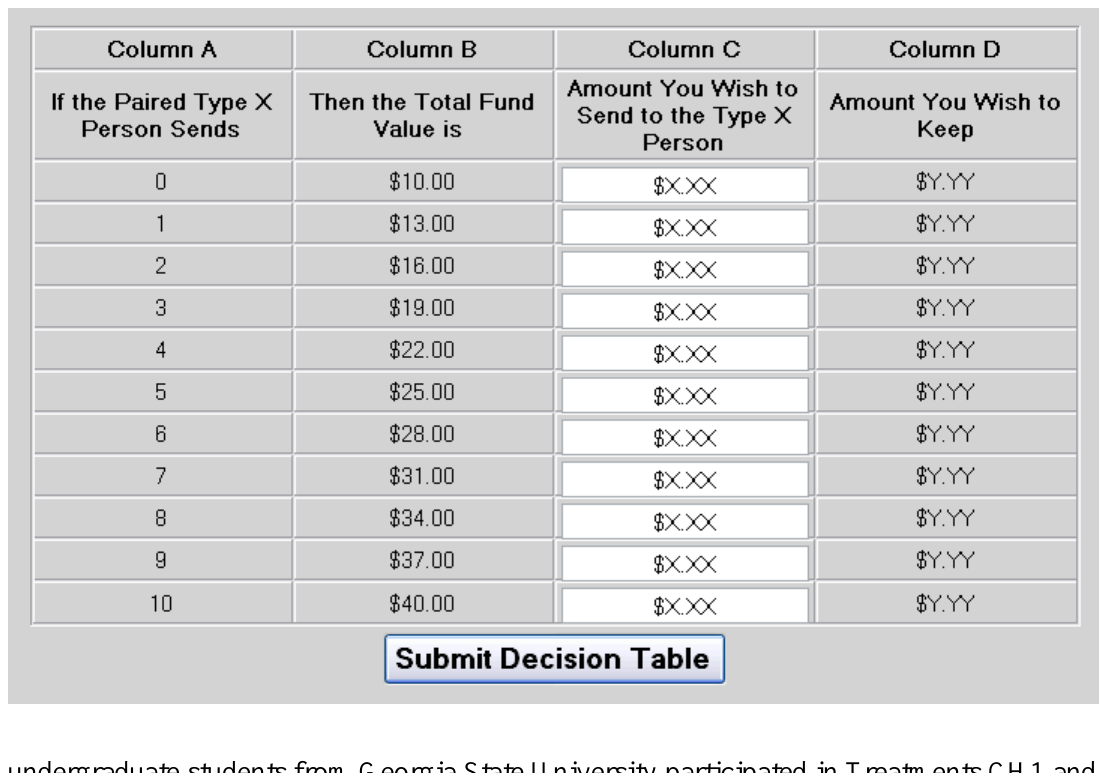
Figure 2. Type Y decision screen for the strategy method